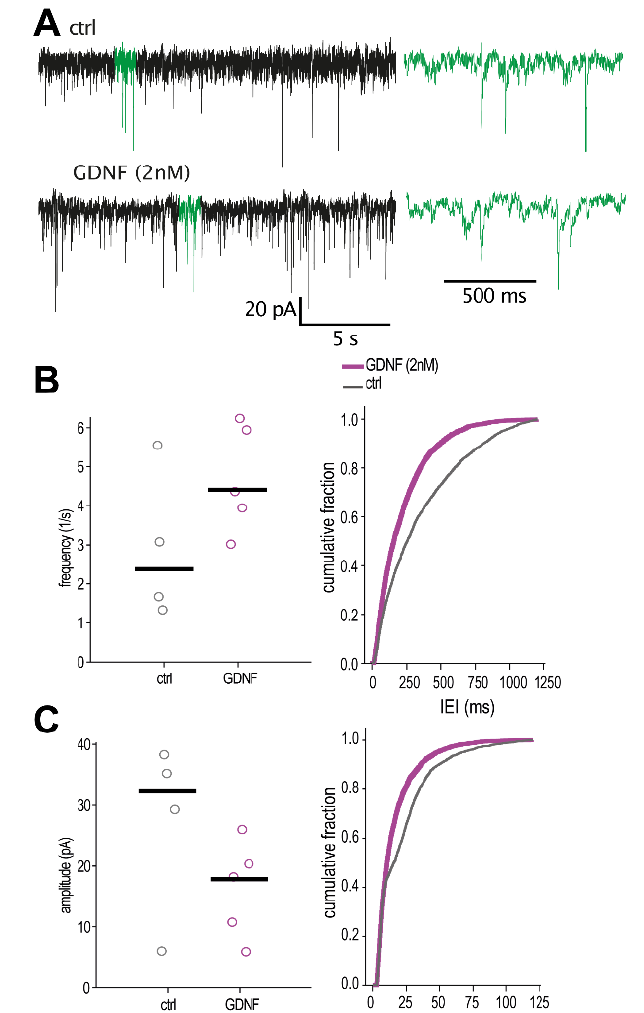
Figure 8. Inter-event interval and amplitude of spontaneous IPSCs from GDNF-incubated human epileptic hippocampal slices. ( A ) Representative traces of sIPSC recordings. Green-colored areas are magnified on the right. Quantification of ( B ) frequency and ( C ) amplitude of spontaneous IPSCs. The line markers in the scatter plots depict the median of averages per cell. Mann–Whitney U-test for the averages–not significant; n = 4 cells for controls and n = 5 cells for GDNF; Kolmogorov–Smirnov test for distribution comparisons, p < 0.01 (IEI: D = 0.238, amplitude: D = 0.199); n = 744 events per cell.